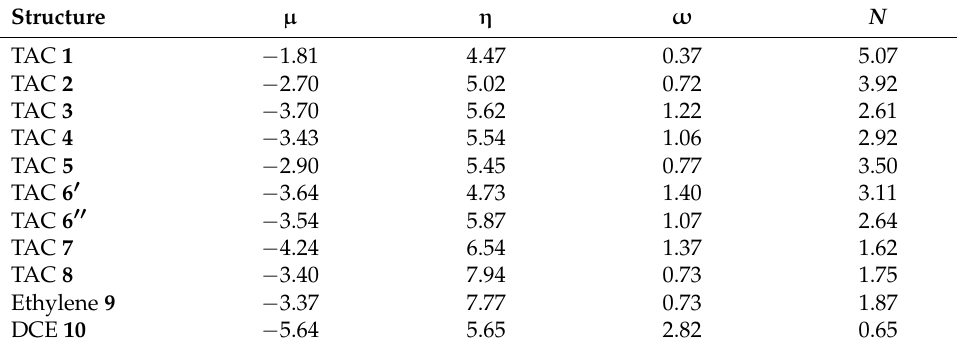
Table 2. B3LYP/6-31G(d) global electronic chemical potential, µ , chemical hardness, η , electrophilicity, ω , and nucleophilicity, N , in eV, of simplest TACs 1 – 8 , ethylene 9 and DCE 10 . Structure